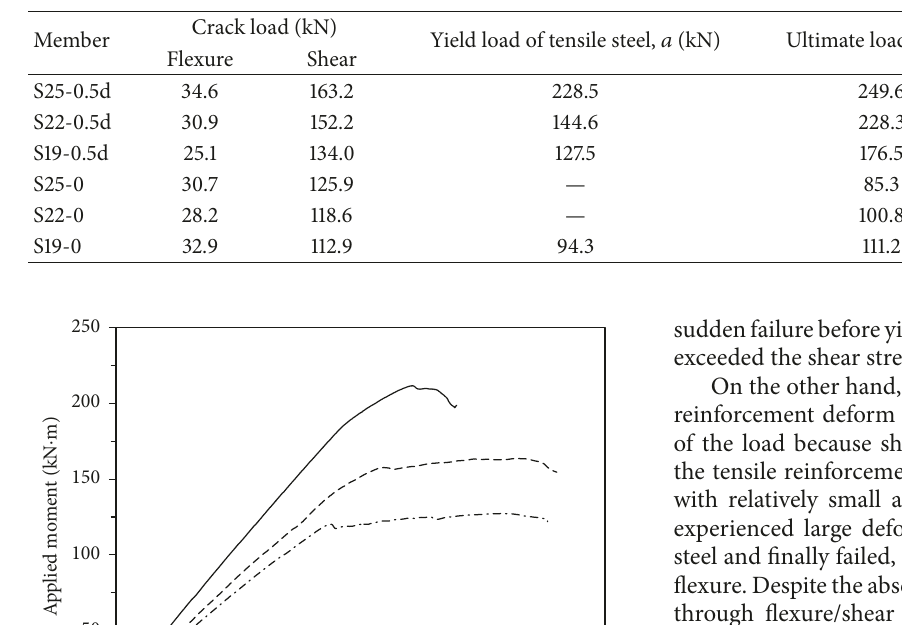
Table 5: Crack, yield, and ultimate loads of shear test specimens.